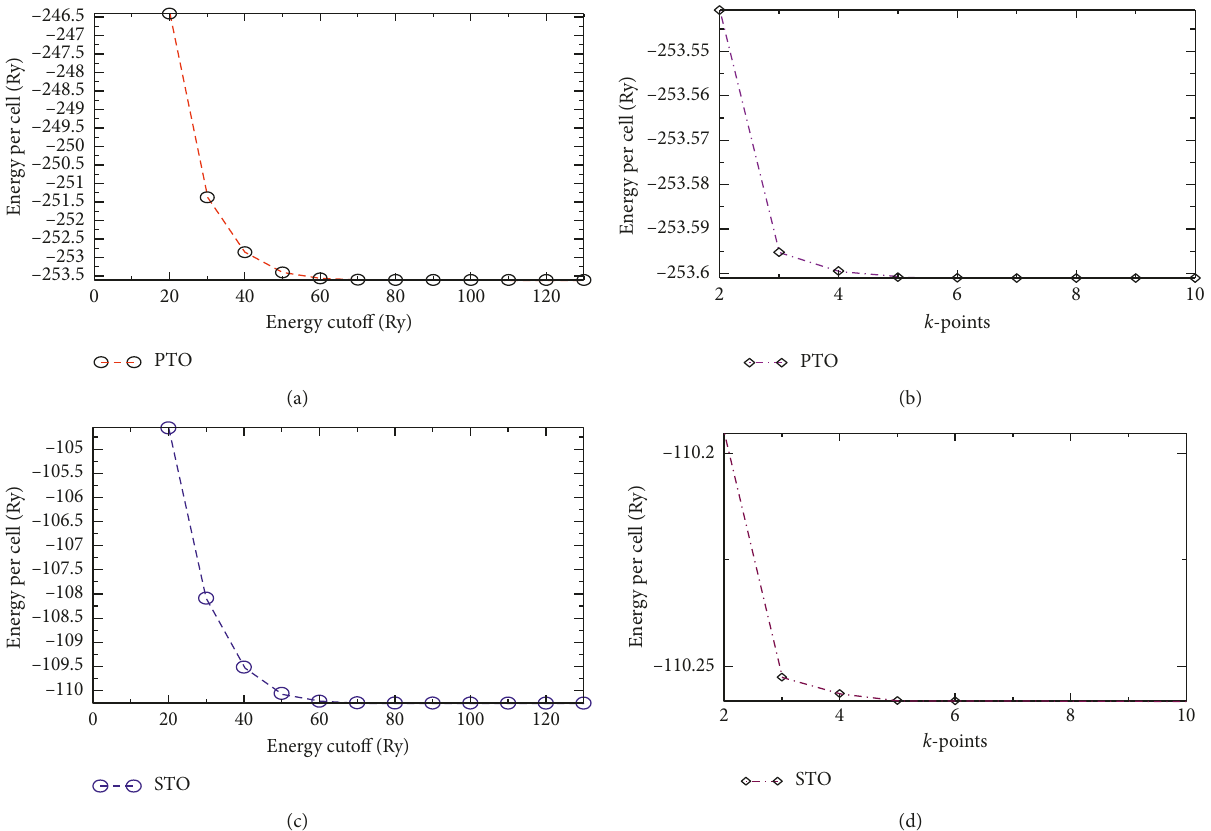
Figure 1: Convergence of absolute energies with respect to cutoff energies and k -point sampling for tetragonal phase of SnTiO